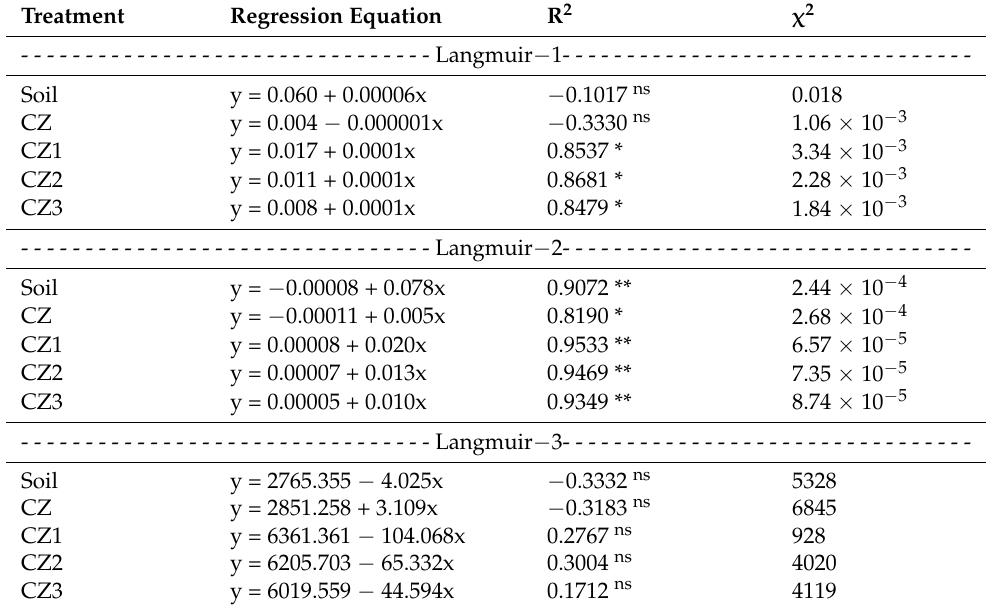
Table 18. Fitting Langmuir type 1, 2, and 3 isotherms to the potassium adsorption data based on simple regression and Chi-square analyses results.